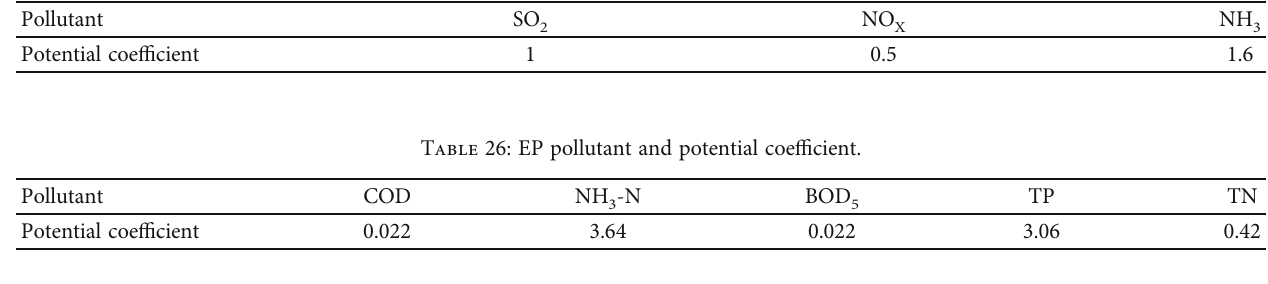
Table 27: HTP pollutant and potential coe ffi cient.